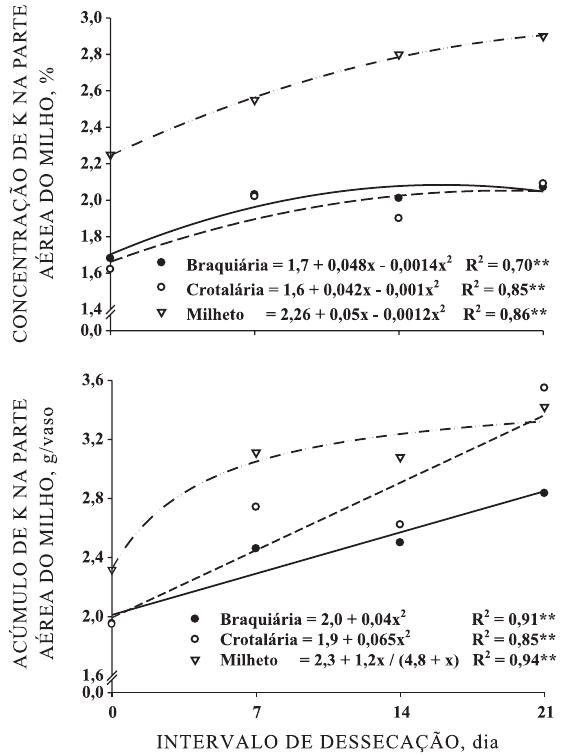
Figura 6. Teor e acúmulo de potássio na planta de milho, em função do intervalo de dessecação, em diferentes espécies de plantas de